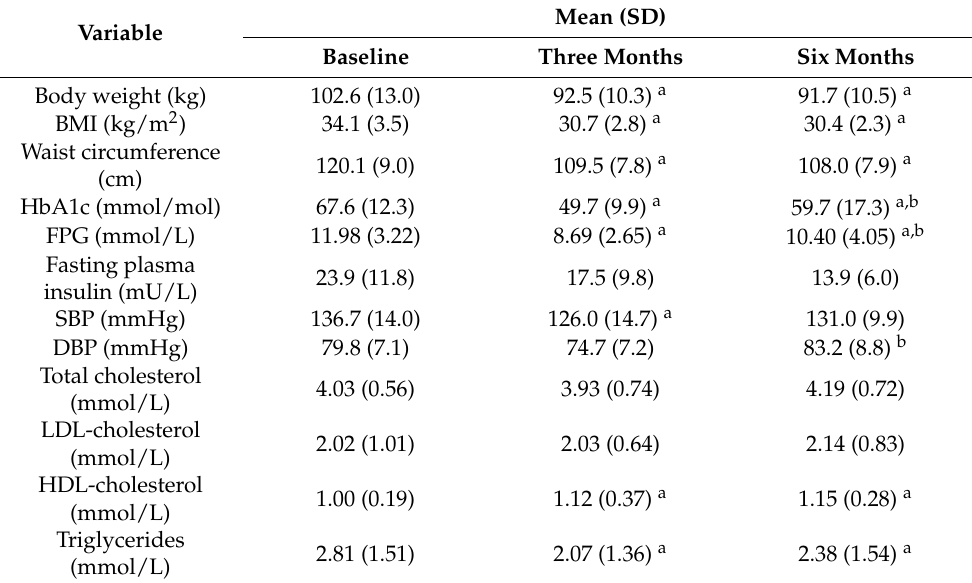
Table 3. Means, standard deviations (SDs), and significant changes in variables from baseline to three months of intervention, from baseline to six months of intervention, and from three months to six months of